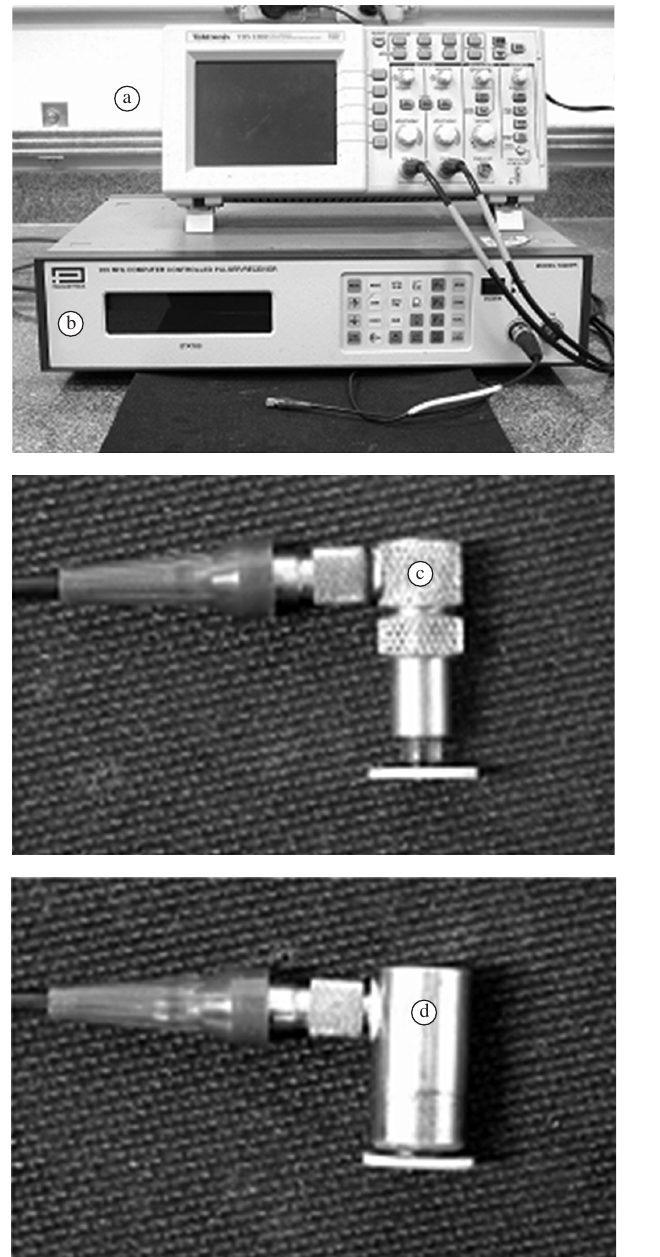
Figure 1. Images of a) oscilloscope, b) ultrasonic pulser-receiver, c) longitudinal wave transducer, and d) shear wave transducer used to measure sonic velocities. In c,d), a disk-shaped specimen in contact with the transducer is also shown.